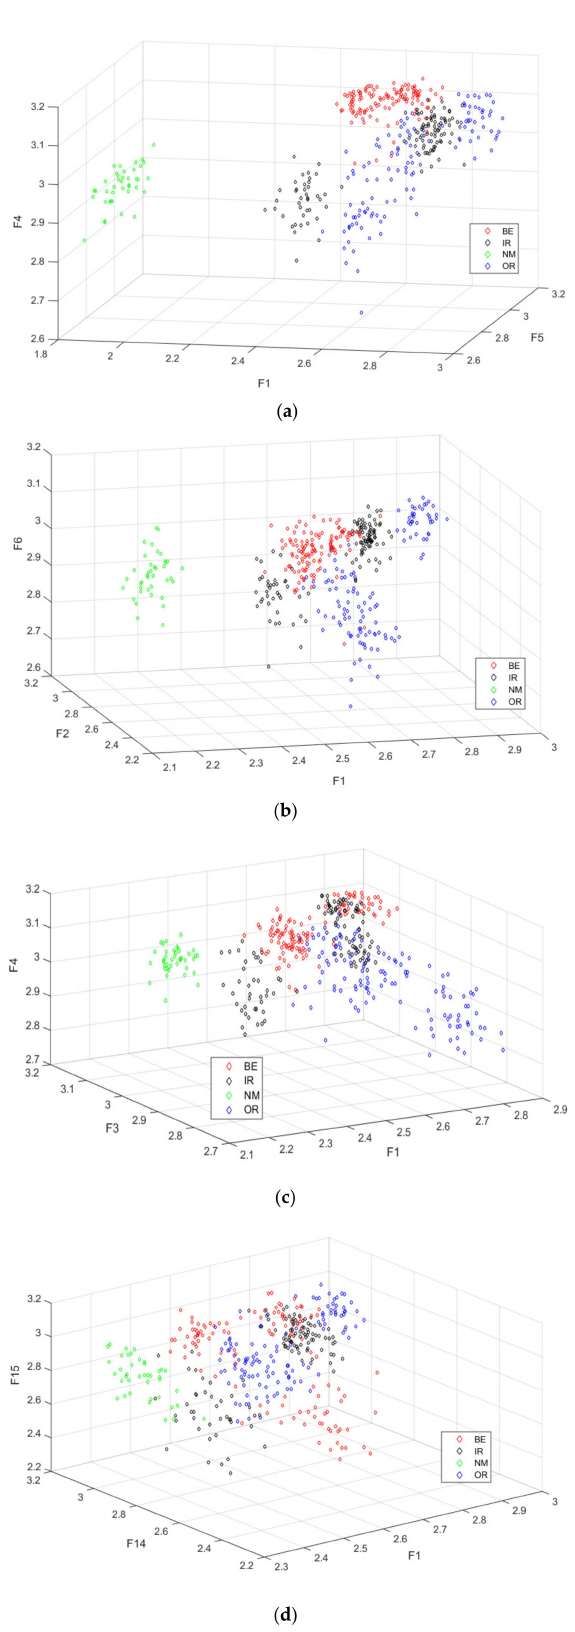
Figure 7. Feature clustering graph of MAAPE with di ff erent loads. ( a ) Load 0 hp. ( b ) Load 1 hp. ( c ) Load 2 hp. ( d ) Load 3